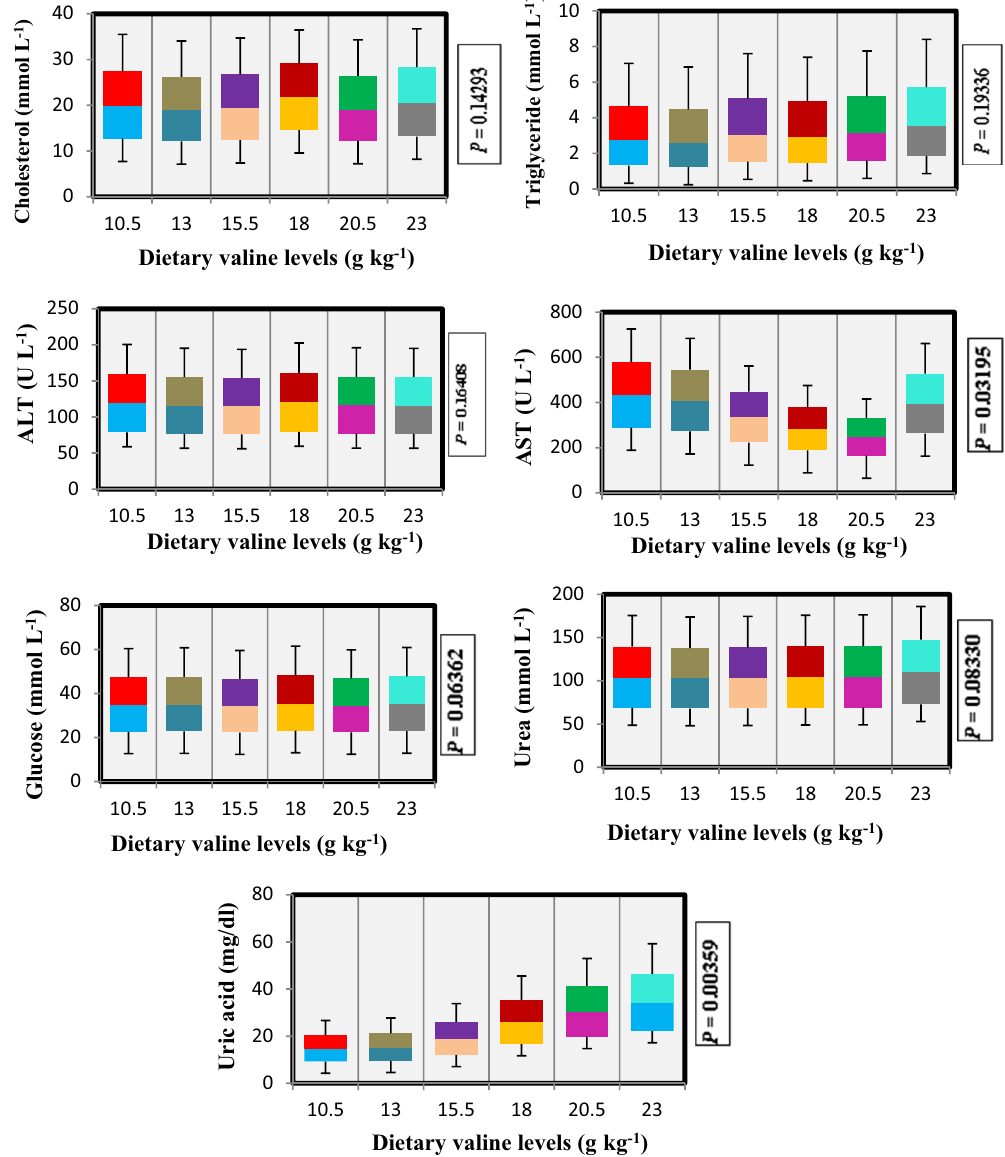
Figure 2. Blood plasma parameters of rainbow trout, Oncorhynchus mykiss fingerlings fed diets containing graded levels of valine (g kg −1